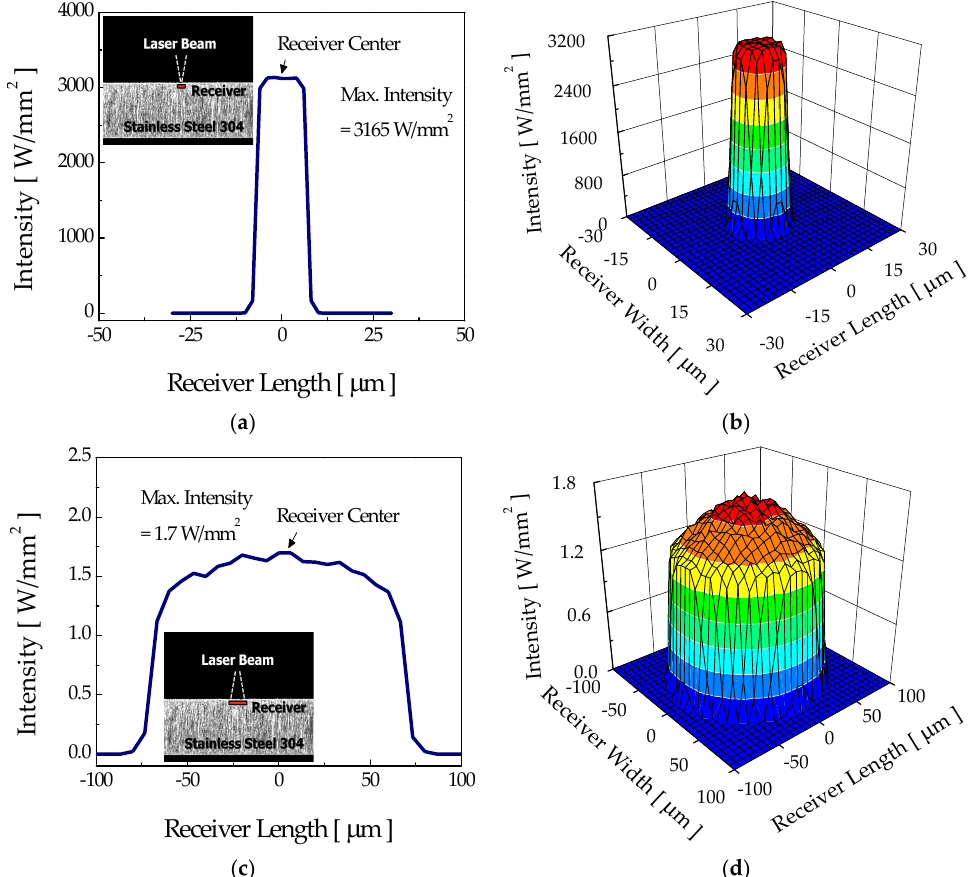
Figure 7. Surface intensity distributions and three-dimensional profiles of the flat surface with no groove which appeared in the ( a , b ) focusing mode and ( c , d ) diverging mode.